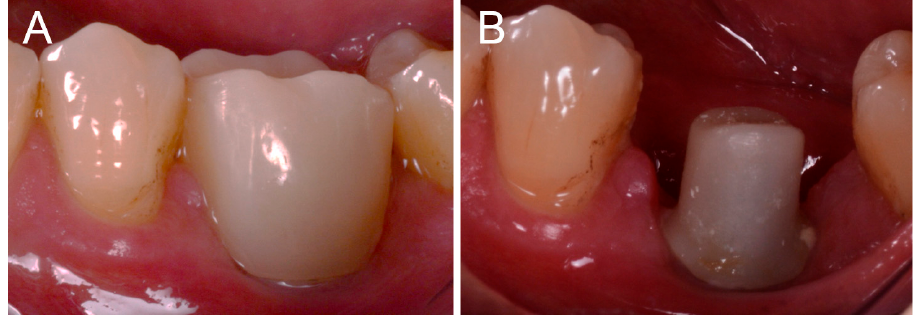
Figure 5. The file of the individual hybrid abutment designed during PLAN1 is saved separately in a dedicated folder as a .STL file (ready to be recovered in the subsequent modeling phase, or PLAN2). ( A ) the mesh with triangles in evidence; ( B ) the integral abutment design.